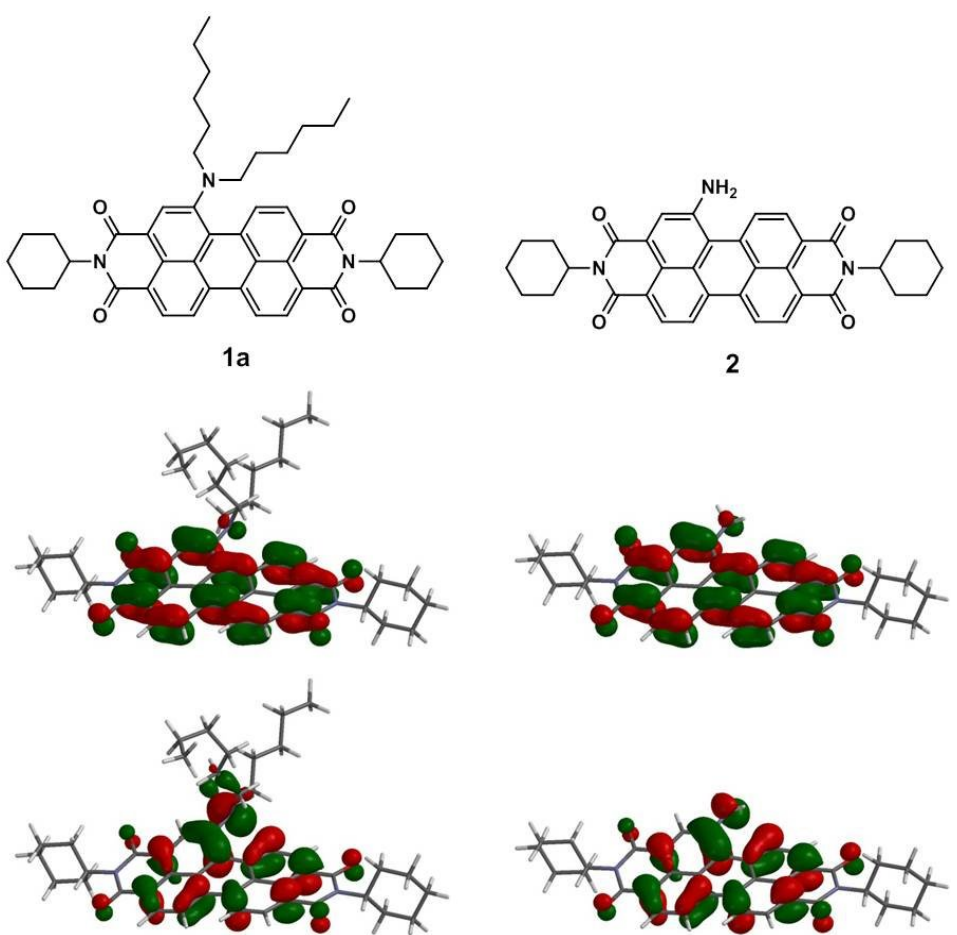
Figure 6. Calculated frontier orbitals for 1a and 2 . The upper structures show the LUMOs and the lower ones show the